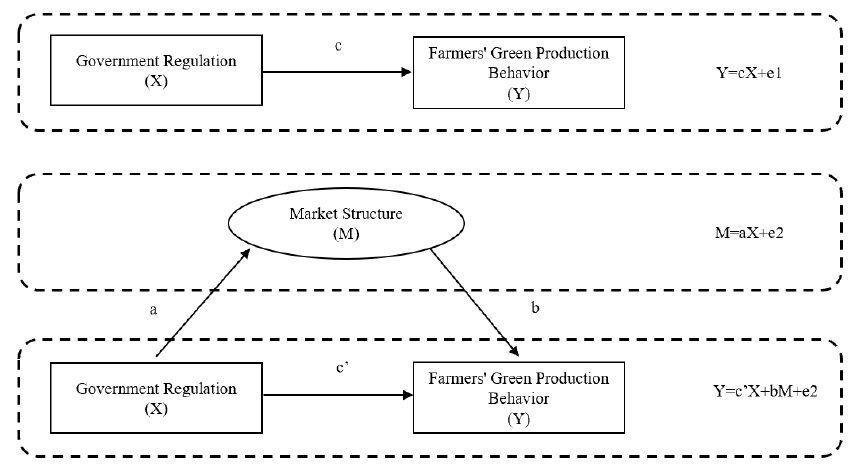
Figure 2. Mediating effect.